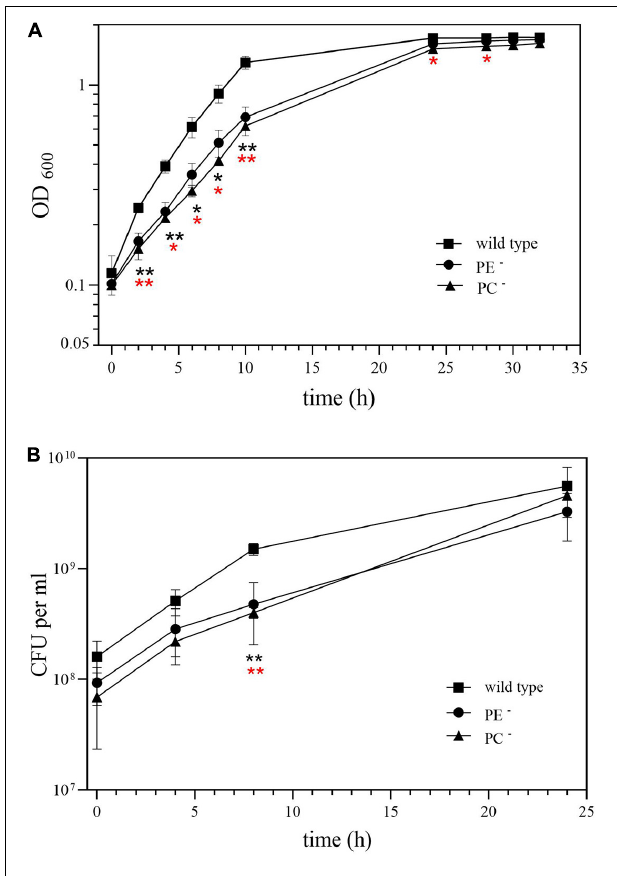
FIGURE 3 | Growth of Sinorhizobium meliloti wild type ( (cid:110) ), PE-deficient mutant CS111 ( (cid:108) ), and PC-deficient mutant OG10017 ( (cid:115) ) on LB/MC+ medium. Growth was recorded by measuring (A) the optical density of cultures at 600 nm (OD 600 ) or by determining (B) the concentration of viable cells as colony-forming units (CFU) per ml. Values represent means of three independent experiments and standard deviation is shown. Statistical analysis was performed by a two-way ANOVA with Tukey’s multiple comparisons test as described in Materials and Methods. Comparisons of the PE-deficient (black asterisks) or the PC-deficient (red asterisks) mutant to wild type are indicated. Statistical significance is shown (* p < 0.05; ** p < 0.01).